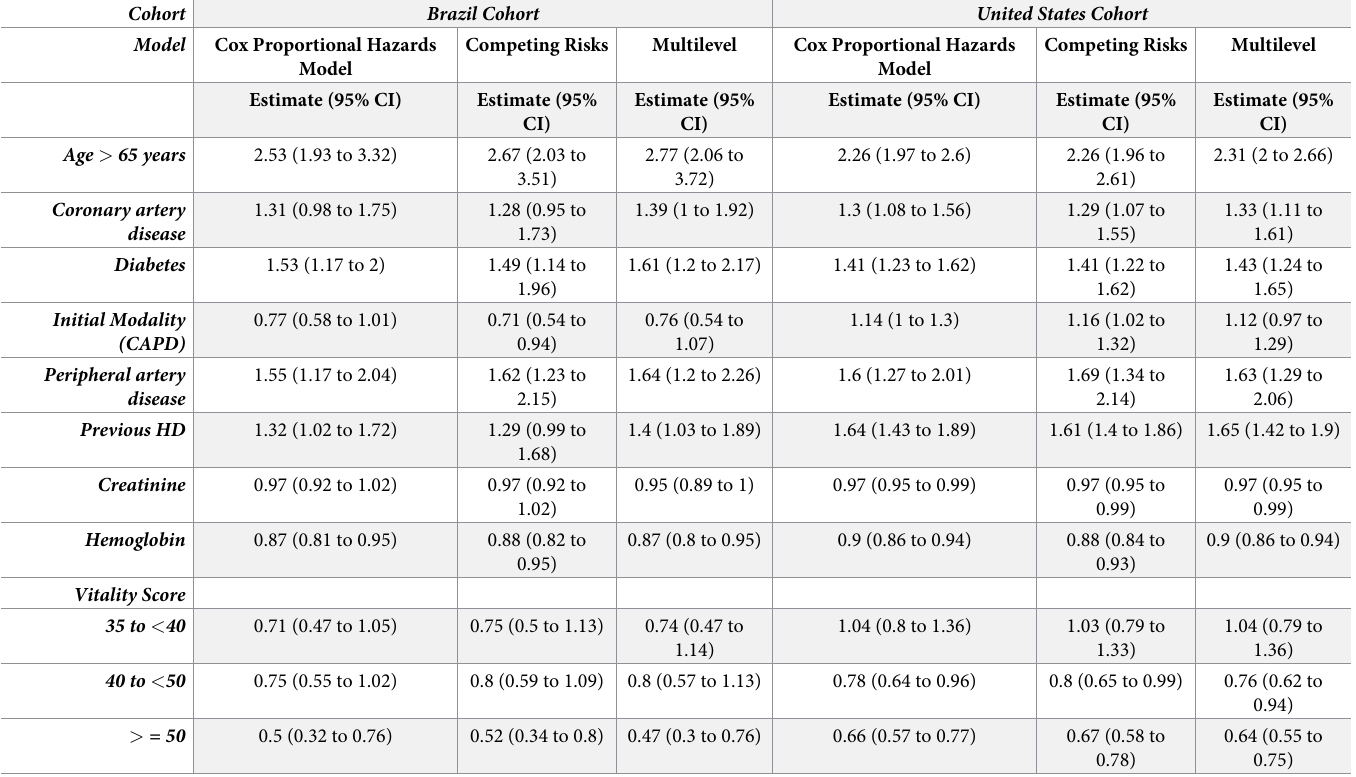
Table 2. Multivariate model estimates for all-cause mortality risk in the Brazil and United States